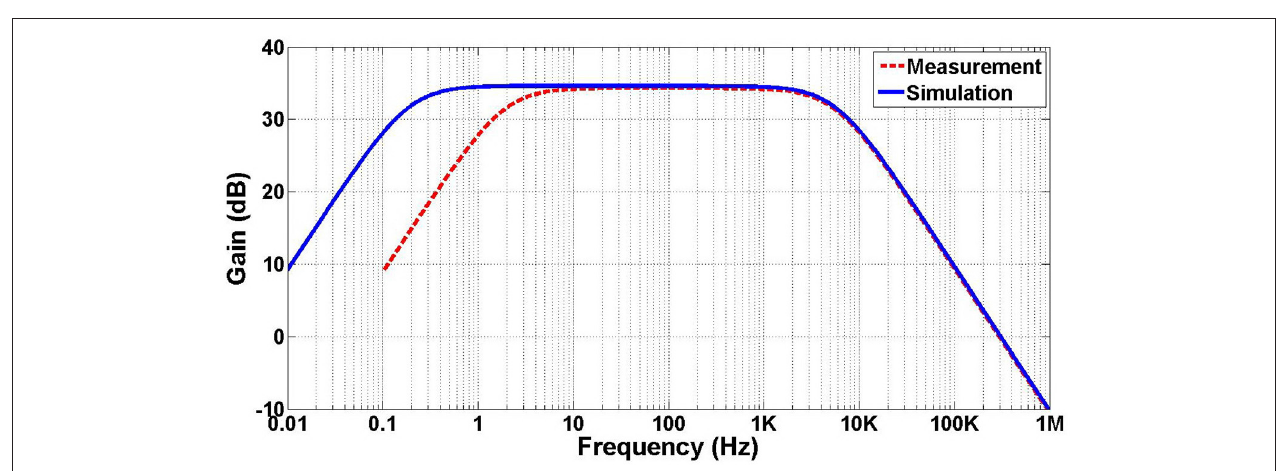
FIGURE 18 | Measured and simulated frequency response of the amplifier. The measured midband gain is 34.3 dB, and the low and high-cutoff frequencies occur at 2 Hz and 5.6 kHz, respectively.